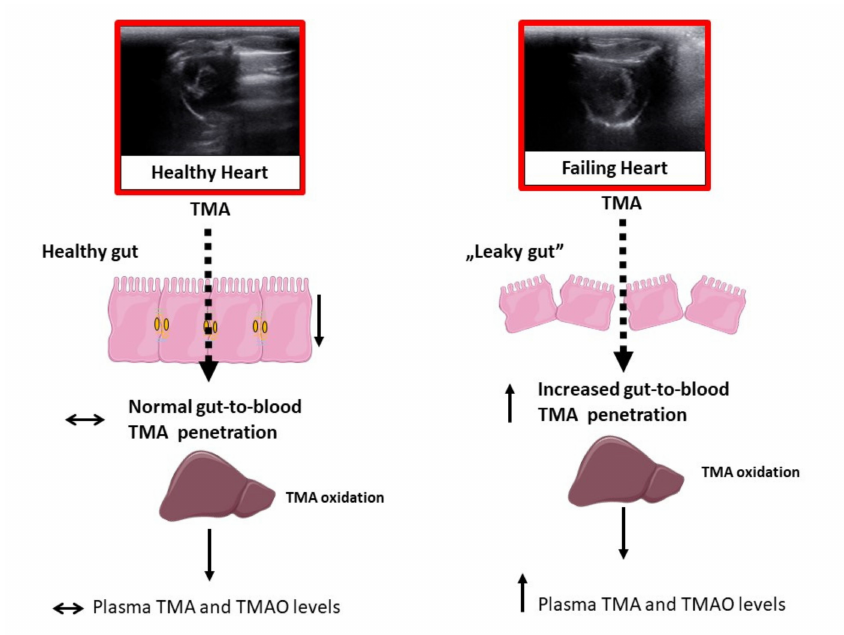
Figure 6. Proposed mechanism of increased plasma levels of trimethylamine oxide (TMAO) in rats with heart failure. Heart failure is associated with structural and functional alterations in the intestinal wall. This increases gut-to-blood penetration of trimethylamine (TMA) which is oxidized to TMAO by the